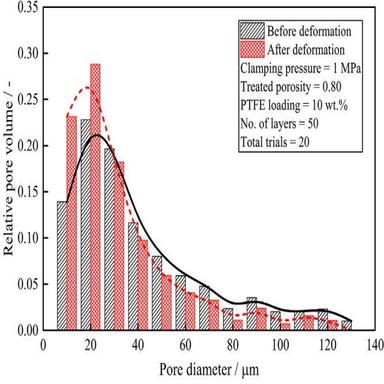
External compression effects on pore size distribution of PTLs.